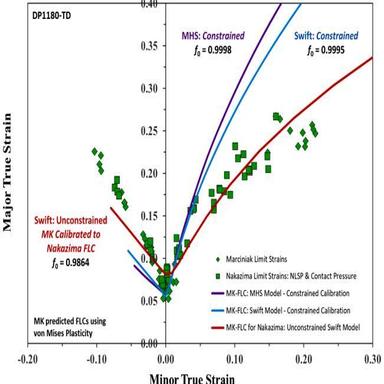
Comparison of MK-predicted FLCs using von Mises plasticity with the Marciniak and process-corrected Nakazima limit strains for DP1180 steel. The unconstrained Swift model calibration using Nakazima data provides the best overall agreement but has introduced several inconsistencies into the MK framework.